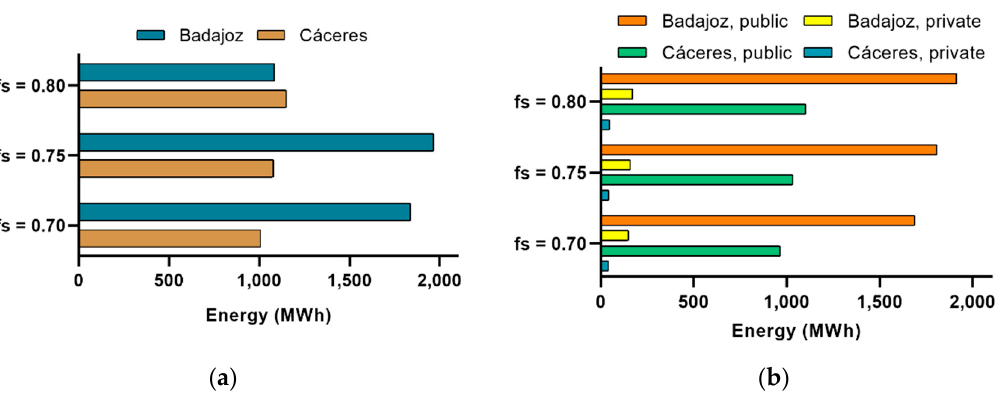
Figure 4. Energy generated by hospitals according to ( a ) province and ( b ) both province and type of management.